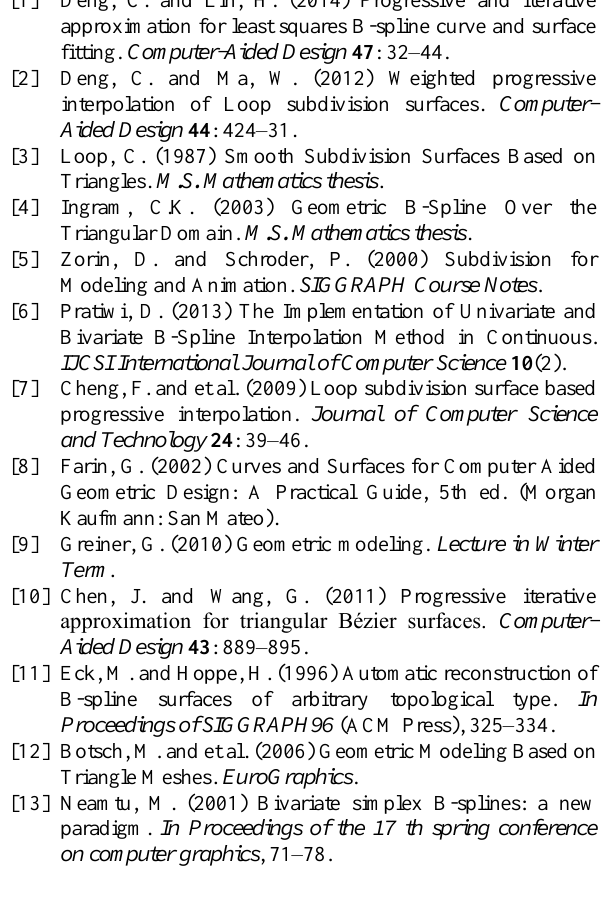
Figure 7. Average errors with respect to the number of iteration k .